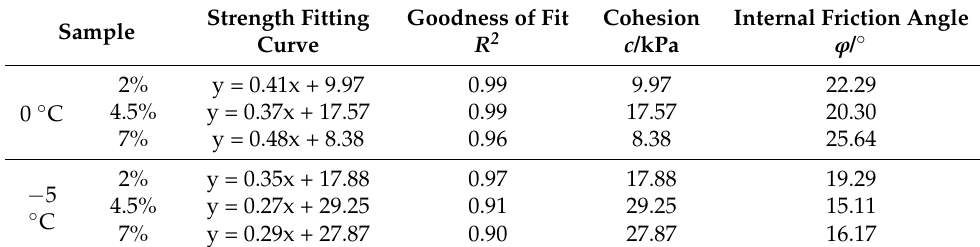
Table 3. Shear strength index of the reinforced soil